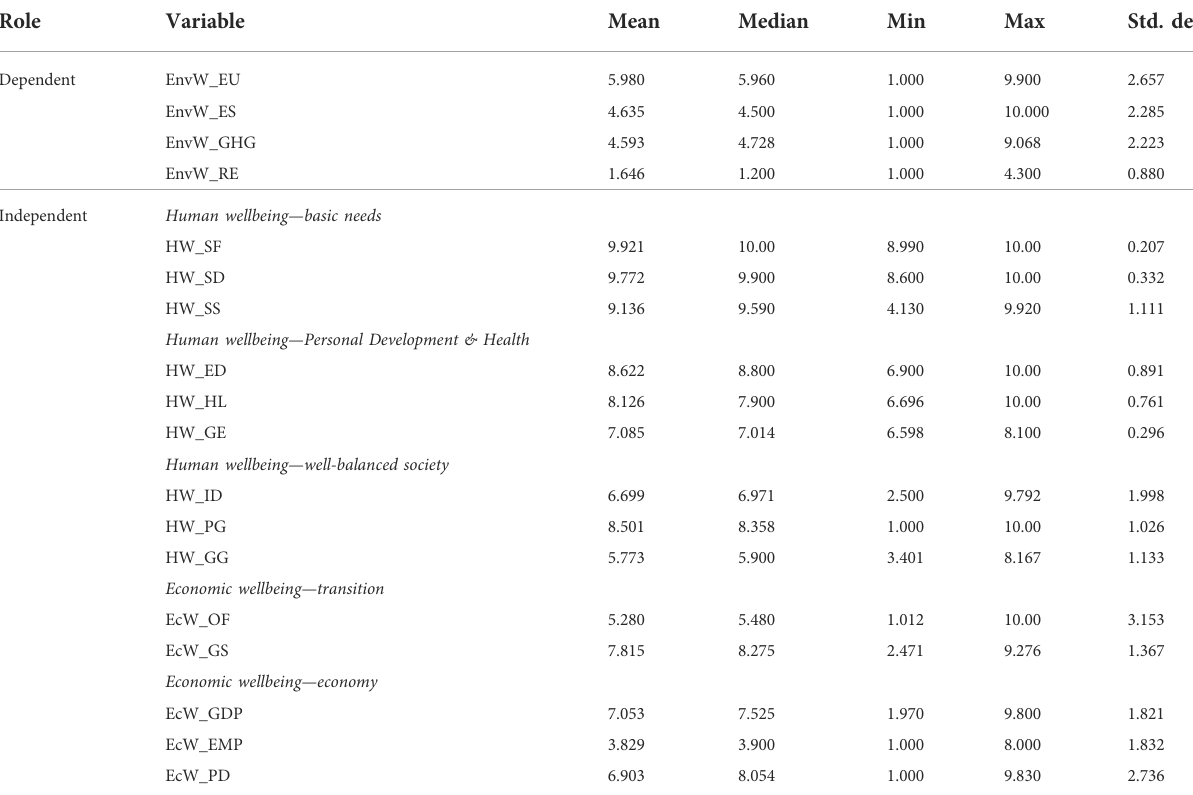
TABLE 3 Statistical description of the variables for all 19 post-communist